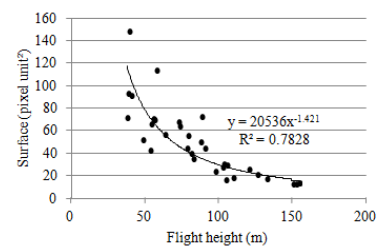
Figure 7: Polynomial regression of the evolution of threshold area between NIA and CEA polygons with flight height.